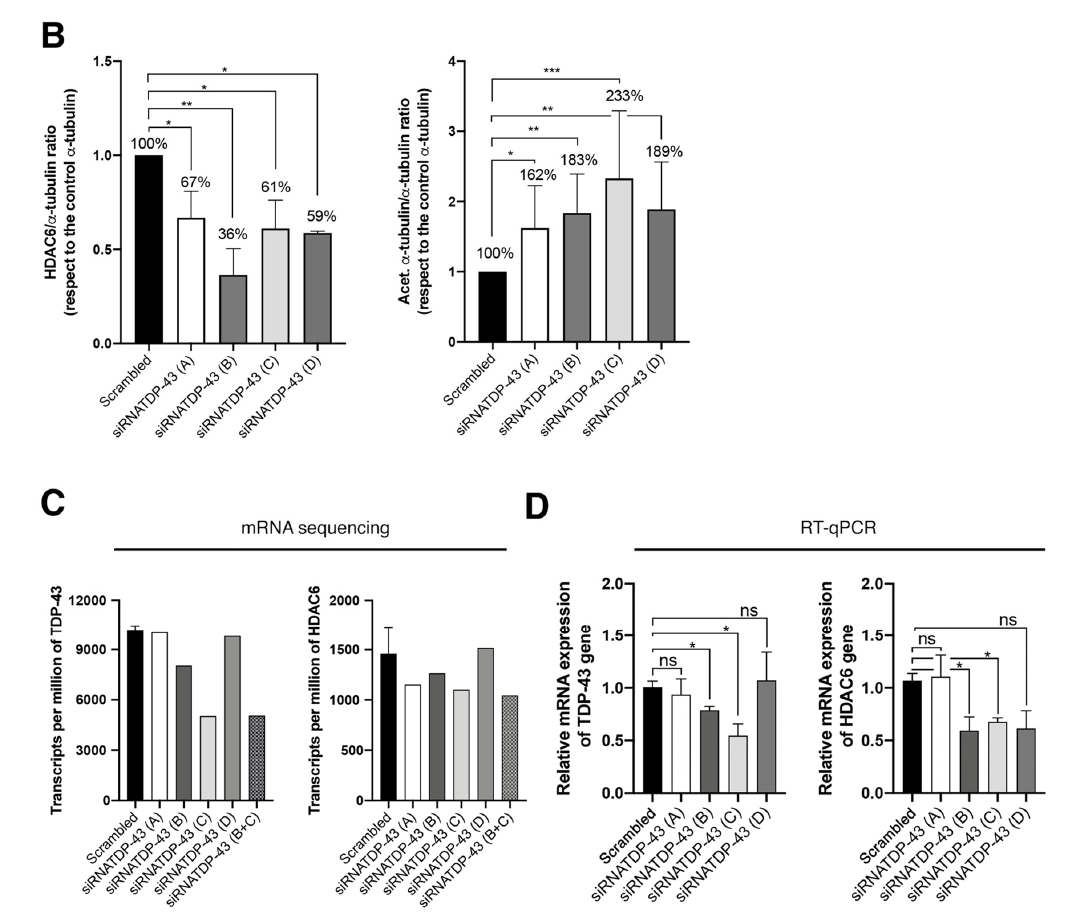
Figure 4. TDP-43 mRNA silencing downregulates HDAC6 mRNA and protein levels. ( A ) Left, Quantitative Western-blot analysis of endogenous TDP-43 knockdown in permissive CEM.NK-CCR5 cells nucleofected with each of the four siRNA-TDP-43 oligos ( A – D ) used (1 µ M of each oligo). Cells nucleofected with scrambled oligos were used as a control. HDAC6/ α -tubulin, TDP-43/ α -tubulin and acetylated/ α -tubulin/ α -tubulin intensity Western-blot band rations are shown. α -tubulin bands represent the control for the total amount of protein. One representative experiment of three is shown (see associated data in Figure S3 and Supplementary Materials associated information). Right, histograms show the quantification of the amount of the TDP-43 protein detected, in respect of the α -tubulin protein, after specific siRNA (A to D oligos) silencing and compared to the scrambled condition. Data are mean ± S.E.M. of three independent experiments (see associated data in Figure S3 and Supplementary Materials associated information). When indicated, ** p < 0.05, and *** p < 0.001 are p values for Student’s t -test. ( B ) Histograms show the quantification of the amount of HDAC6 and acetylated α -tubulin protein detected, with respect to the α -tubulin protein, after specific siRNA (A to D oligos) silencing and compared to the scrambled condition. Data are mean ± S.E.M. of three independent experiments ( see associated data in Figure S3 and Supplementary Materials associated information ). When indicated, * p < 0.01, ** p < 0.05 and *** p < 0.001 are p values for Student’s t -test. ( C , D ) Relative mRNA quantification in transcripts per million by sequencing (1 repeat) ( C ) or by RT-qPCR (3 repeats) ( D ) of TDP-43 and HDAC6 genes is represented in histograms after oligo interference directed to TDP-43 mRNA by either individual siRNA ( A – D ) oligo or combining siRNA B + C oligos, and compared to the scrambled condition. Data are normalized to the expression of total α -tubulin. When indicated, * p < 0.01 is the p value for Student’s t -test; n.s. stands for